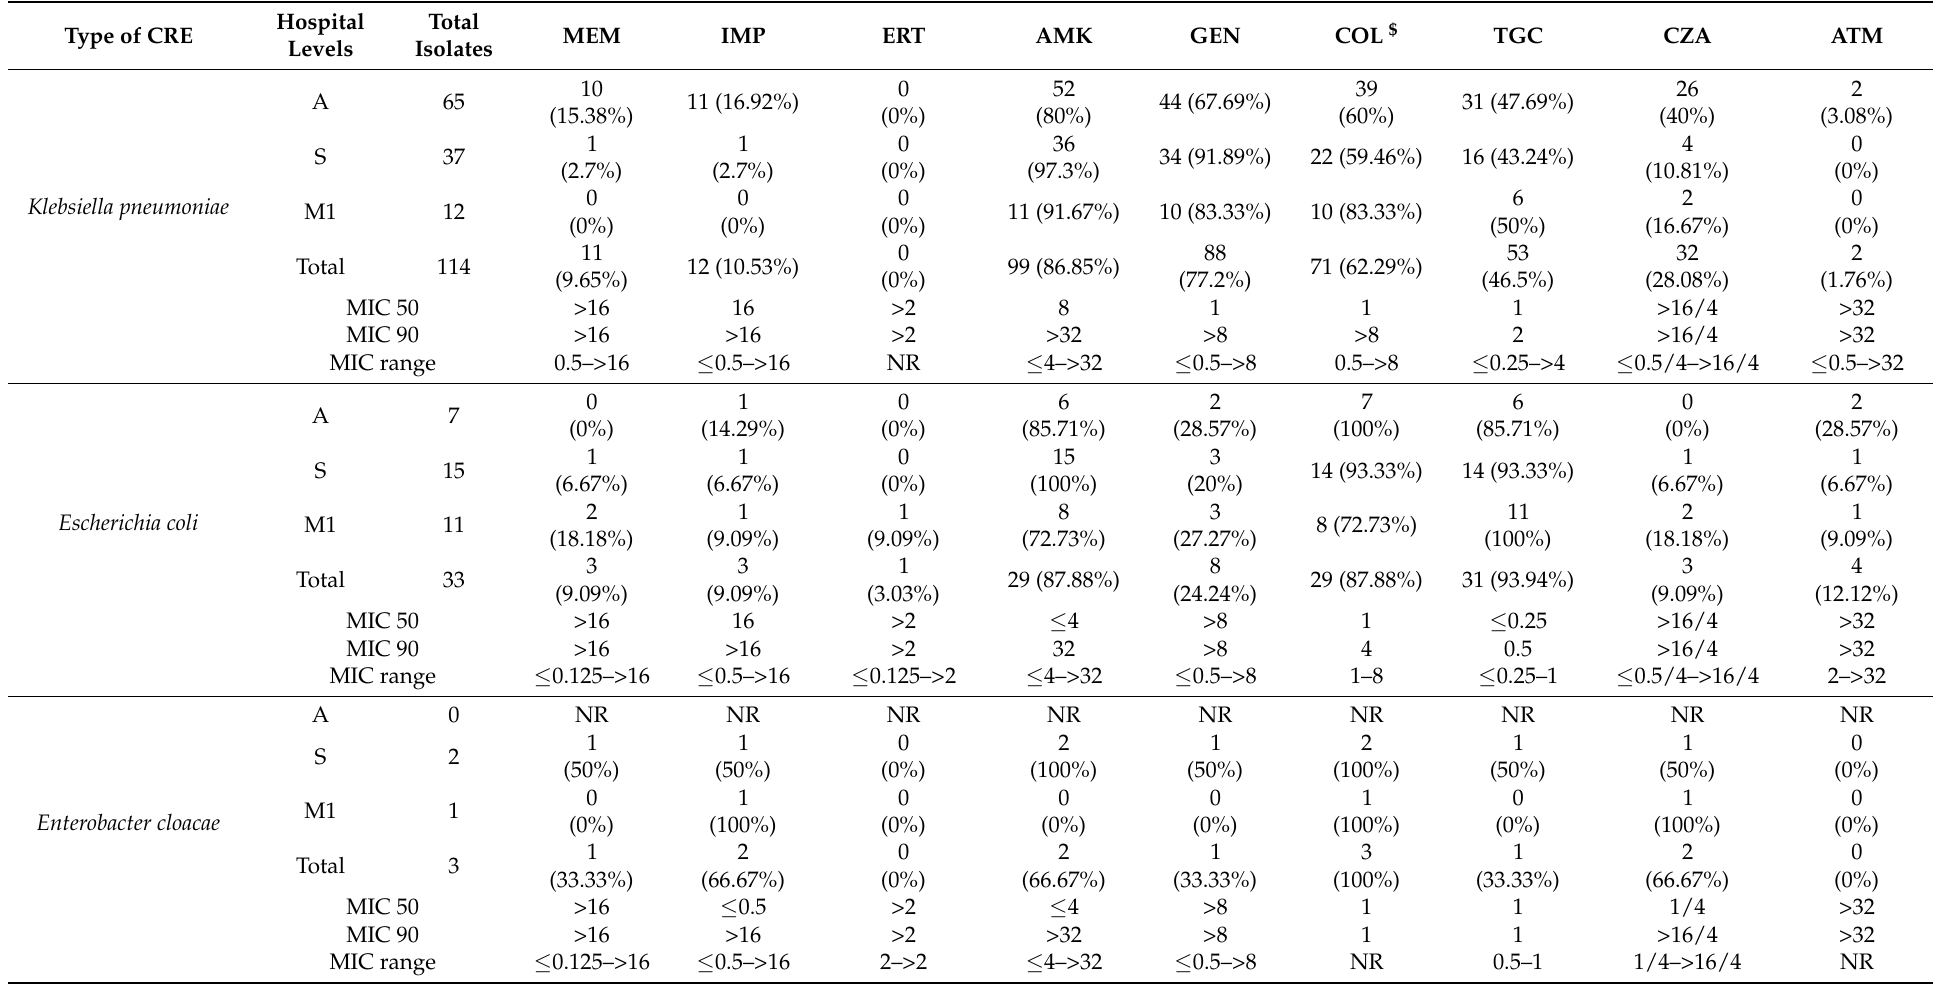
Table 1. Susceptible rates, MIC 50, MIC 90, and MIC ranges of Klebsiella pneumoniae , Escherichia coli and Enterobacter cloacae for several studied antibiotics grouped by the type of CRE at each hospital